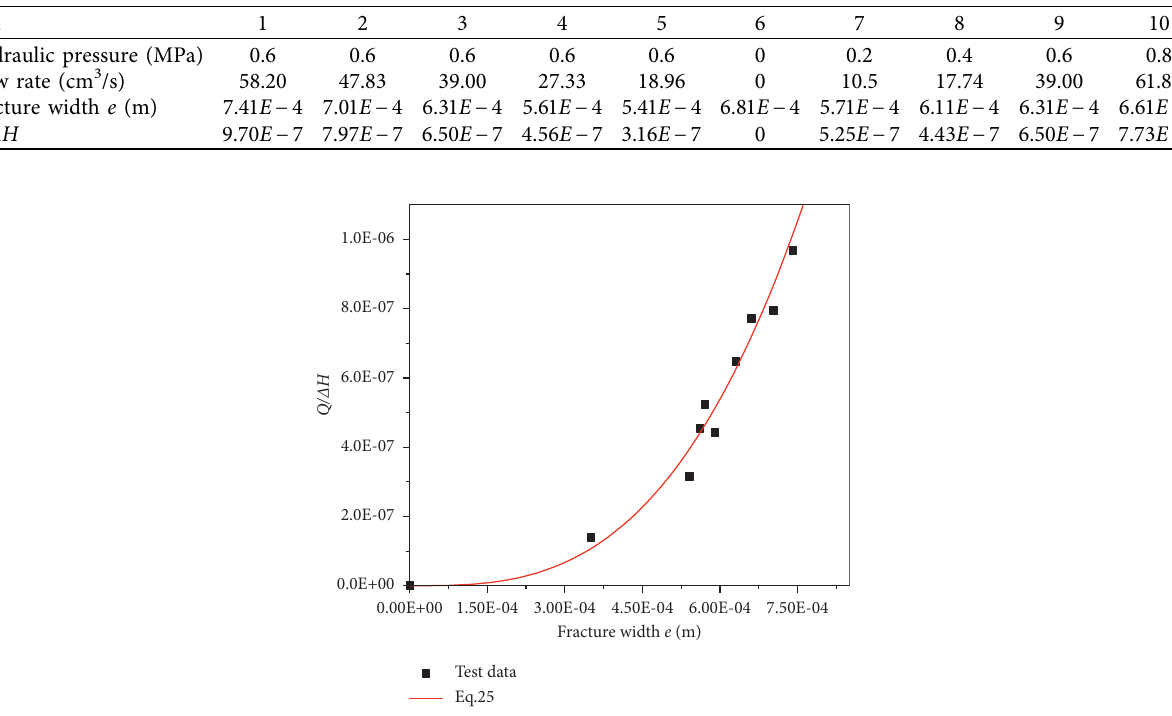
Table 6: Relationship between fracture aperture and flow rate under different working conditions.